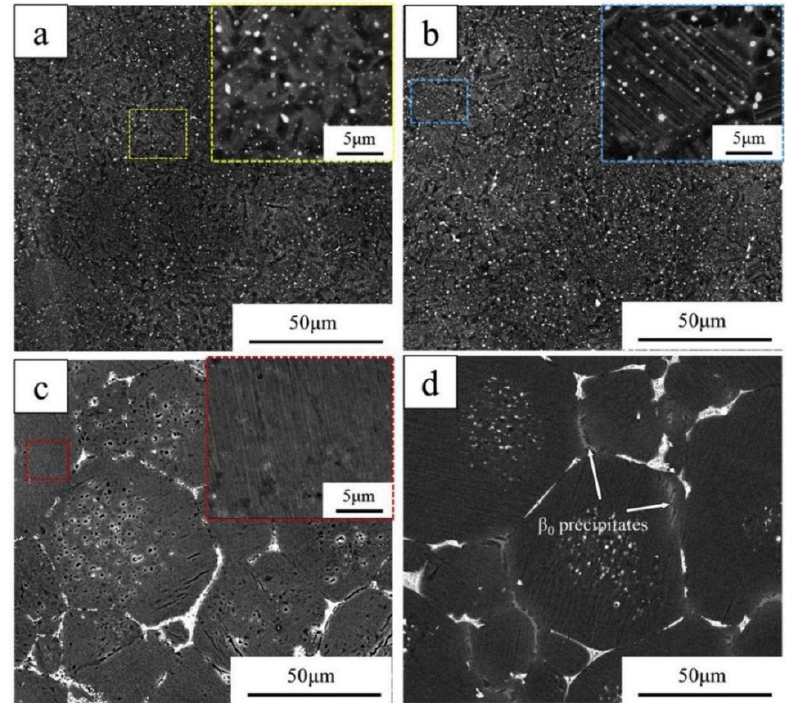
Figure 12. Scanning electron microscope (SEM) images of yttrium added TiAl alloys produced by SPS with ( a ) outer part of sample sintered at 1100 °C; ( b ) center of sample sintered at 1150 °C; ( c ) sample sintered at 1200 °C; and ( d ) 1250 °C (reproduced from [27], with permission from Elsevier, 2020).